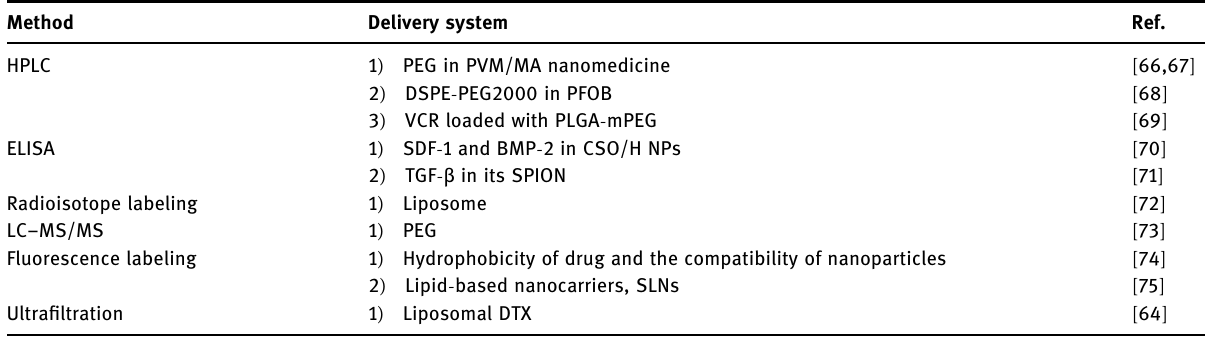
Table 1: Analytical methods and their examples for the bioanalysis of NDDS